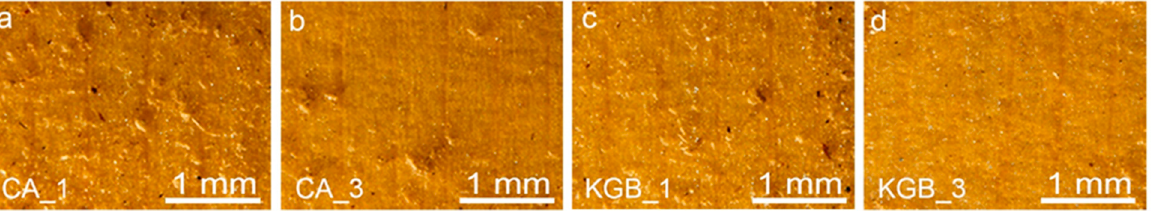
Figure 5. Images by stereomicroscope of the soiled-WM cleaned by CA gel and KGB gel at different